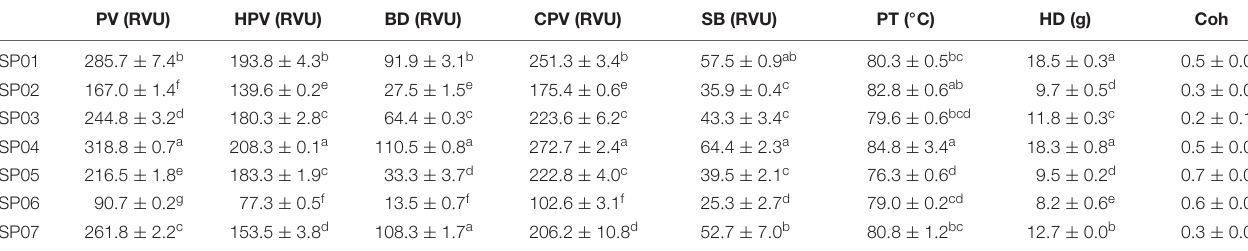
TABLE 5 | Pasting properties and textural properties of different varieties of sweet potato